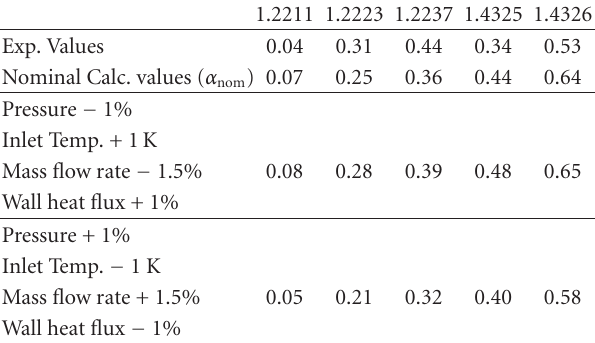
Table 6: Calculated void-fraction values with two “opposite” sets of parameters.